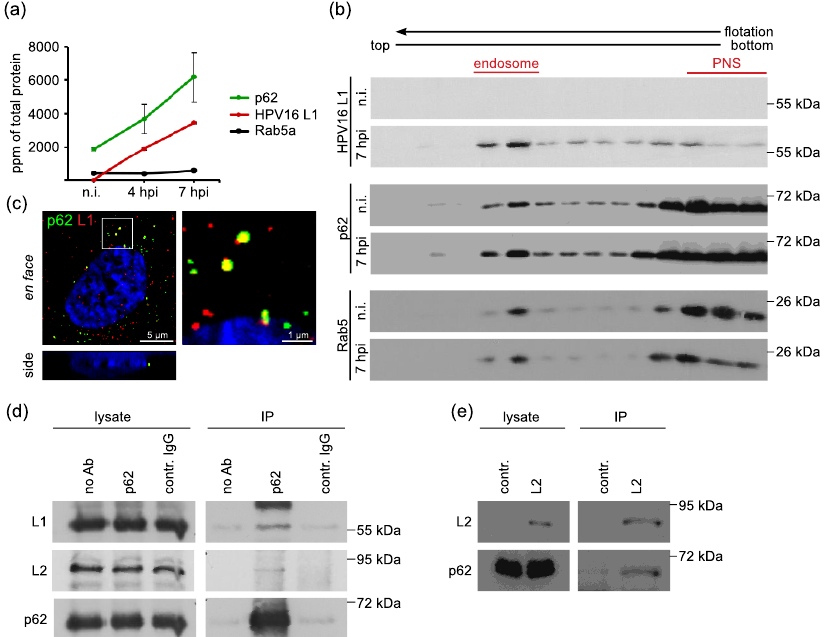
Figure 1. P62 is recruited to HPV16 PsV-filled endosomes and forms a complex with incoming PsVs and overexpressed L2. ( a , b ) Endosomal p62 level increases post PsV addition. HeLa cells were incubated with PsVs for 4 or 7 h (hours post infection, hpi) or left untreated (non-infected, n.i.), and endosomes are isolated by sucrose gradient centrifugation. ( a ) Parts per million (ppm) values of total protein for p62, HPV16 L1, and Rab5a protein of endosomal fraction determined by label-free quantitative mass spectrometry (see also Figure S1). The graph shows the mean of two independent experiments. Error bars show mean value ± standard error of the mean (SEM). ( b ) Western blot of HPV16 L1, p62 and Rab5 in sucrose gradient fractions. Rab5 serves as a marker for early endosomes. Endosomal fraction marked in Western blot was used in mass spectrometry. Western blot fractions marked with PNS represent post-nuclear supernatant rich in soluble cytoplasmic proteins such as Rab5. ( c ) Representative picture of p62 (green) and L1 (red) co-localization in HeLa cells. HeLa cells were incubated with PsVs for 7 h and stained with p62-specific mAb and L1-specific pAb K75. The box in the left panel marks the outline of p62 and L1 co-localization shown in higher magnification in the right panel. The picture shows both en face (xy) and side view (xz). The side view was generated from z-stacks. Nuclei are stained in blue (Hoechst 33342). ( d ) Co-immunoprecipitation of p62 and HPV16 capsid proteins. HeLa cells were incubated with PsVs for 18 h. Cells were lysed and incubated with p62-specific mAb for immunoprecipitation. Protein input was verified by Western blotting of whole cell lysates using specific antibodies. P62 immunoprecipitation and L1 and L2 co-immunoprecipitation were detected by Western blotting using p62- (mAb), L1- (pAb K75) or L2- (mAb L2-1) specific antibodies. ( e ) Co-immunoprecipitation of HPV16 minor capsid protein L2 and p62. HeLa cells were transfected with empty control or L2 plasmid for 24 h. Protein input was verified by Western blot of whole cell lysates using specific antibodies. The p62 precipitations and L2 co-immunoprecipitations were detected by Western blotting using anti-L2 or anti-p62 mAbs.